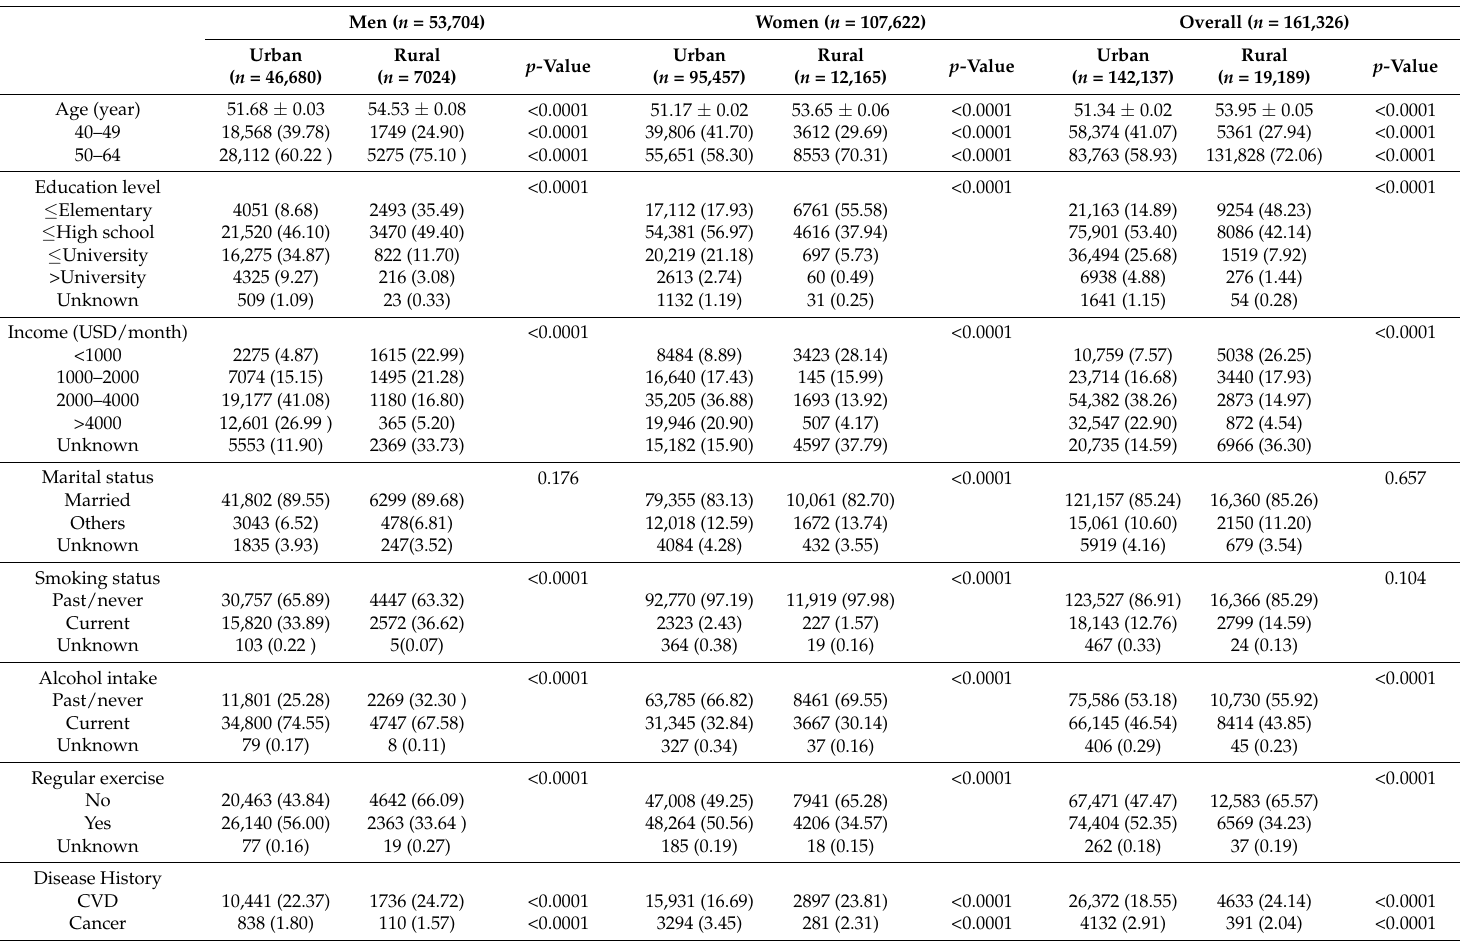
Table 1. General characteristics of rural and urban Korean adults aged 40–64, CAVAS (2005-2011) and HEXA (2004–2013)